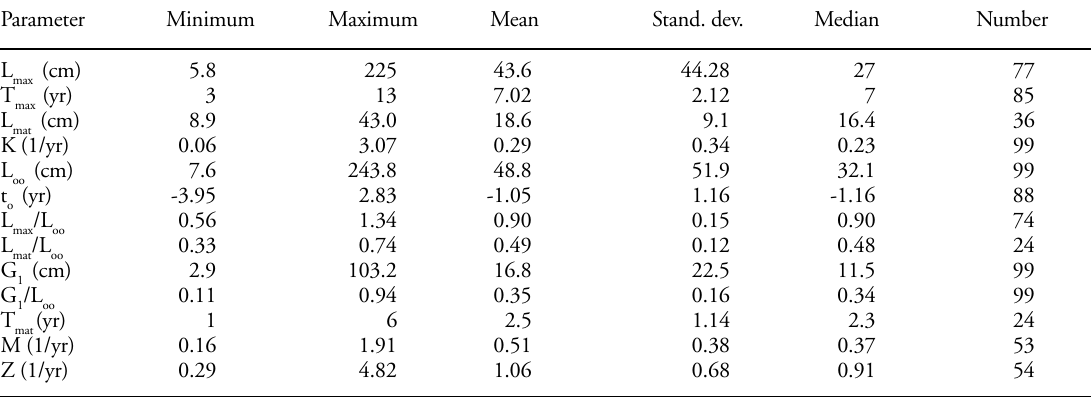
Table 1. Statistical analysis of various available life-history parameters of marine fishes in Hellenic waters. For symbols see material and methods. Original data set from Stergiou et al. (1997). Parameter Minimum Maximum Mean Stand. dev.